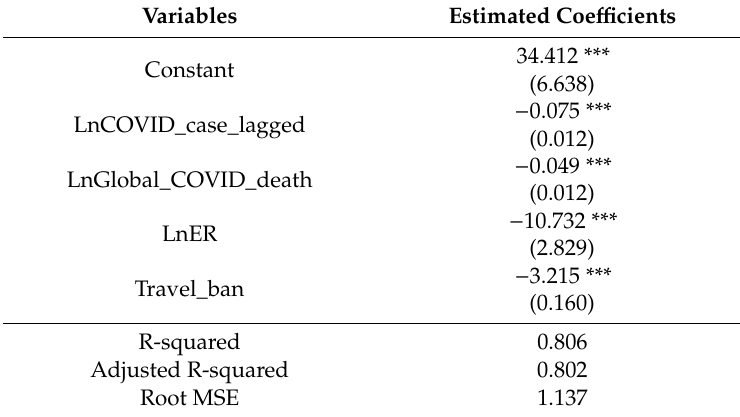
Table 4. Estimation results of FE model with an additional variable of Global deaths by